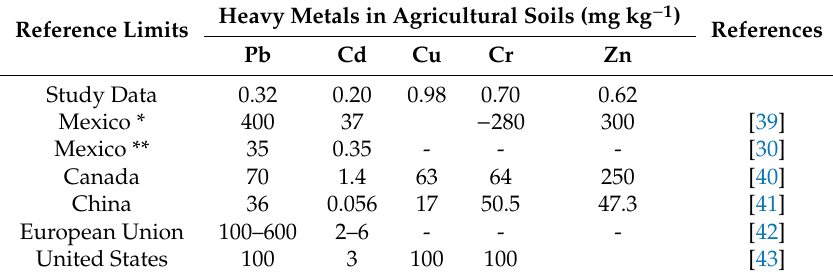
Table 3. Established reference limits for heavy metals for agricultural use in di ff erent